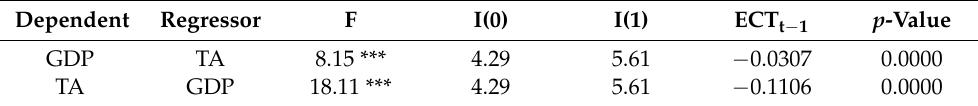
Table 4. ARDL bounds test of cointegration with mediating variables +.